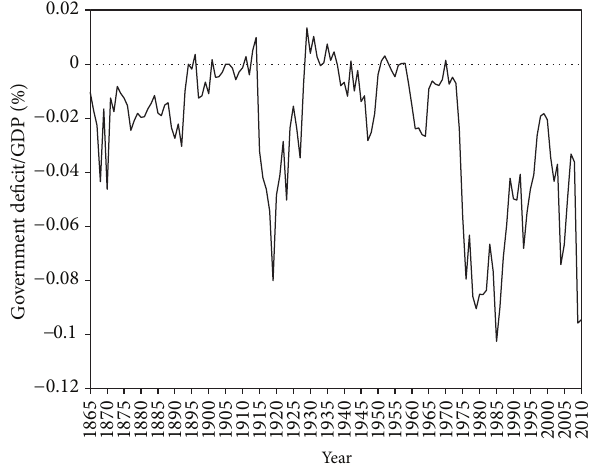
Figure 16: The government budget performance (surpluses on the positive axis and deficits on the negative axis): government deficit/GDP (%) (sources: before 1998 [25]. For the last years [26,